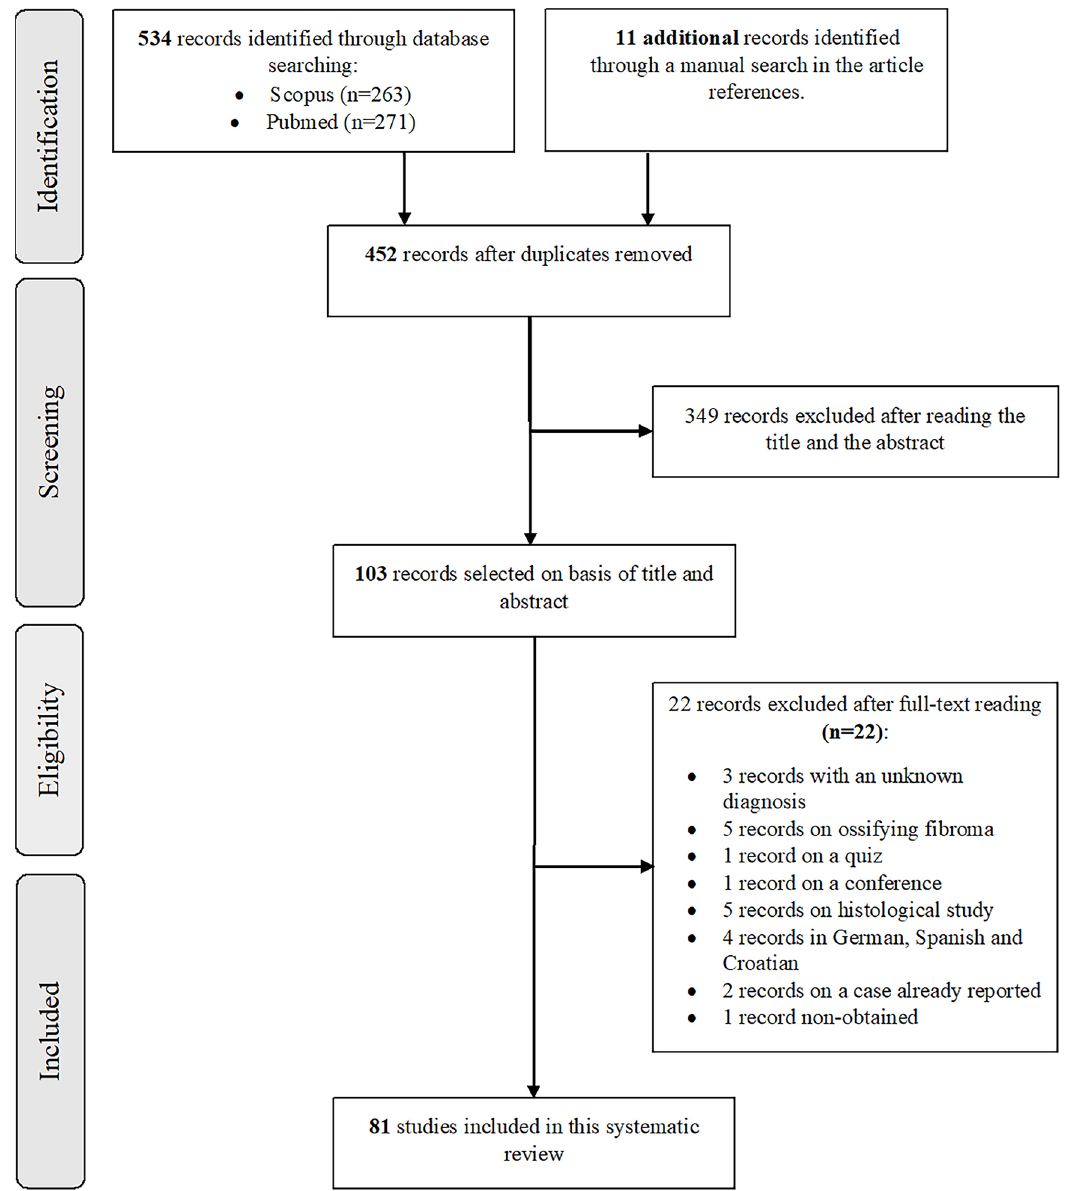
Fig. 1. PRISMA fl owchart of the systematic literature